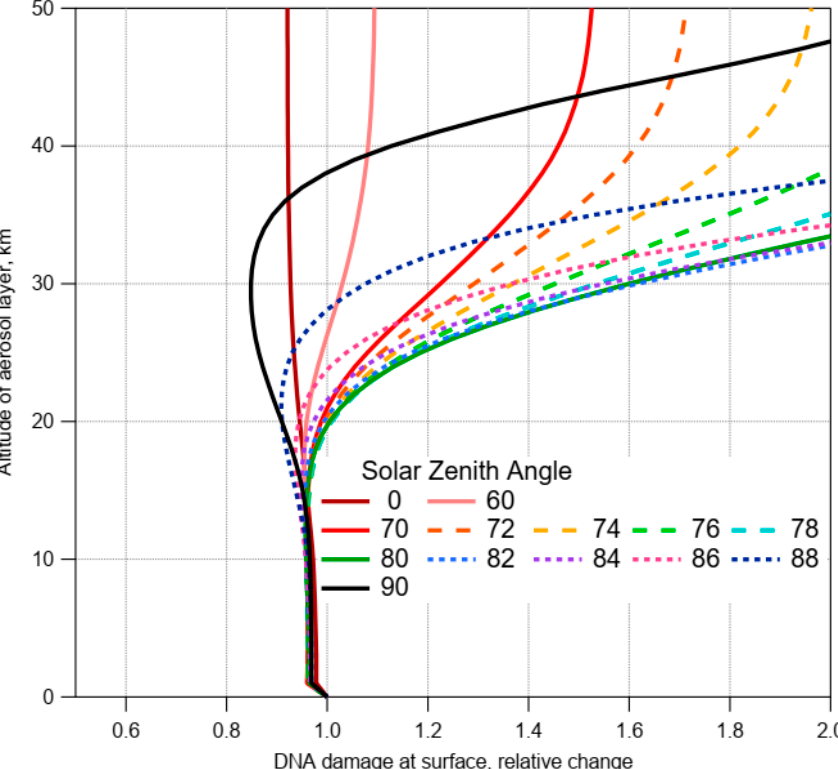
Figure 3. Changes in ground-level DNA-damaging irradiance ( x -axis), when adding a hypothetical, 1 km thick, single aerosol layer (optical depth = 0.2), at different altitudes ( y -axis) in an otherwise aerosol-free atmosphere.